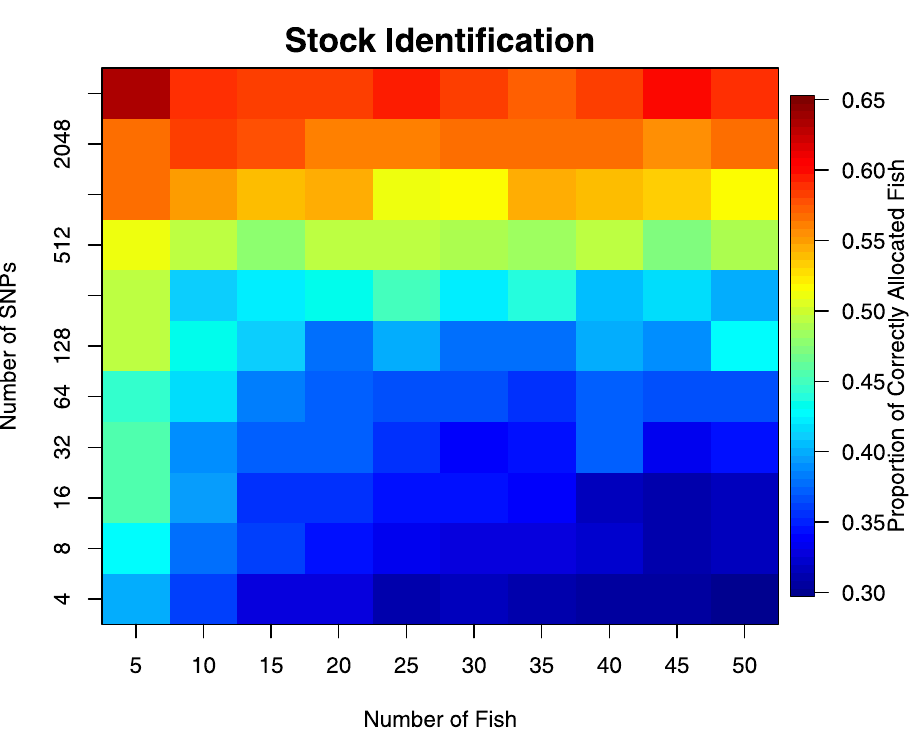
Fig 5. Results from stock identification analysis from the resampling experiment. Lower values (cooler colours) represent poorer delineation. This experiment attempted to delineate all four regions.